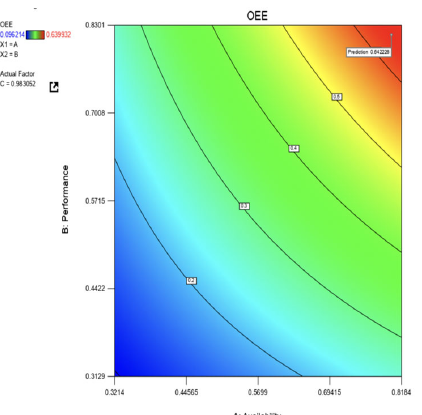
Fig. 9. OEE contour plot – Performance vs Availability Fig. 10. OEE contour plot – Quality vs